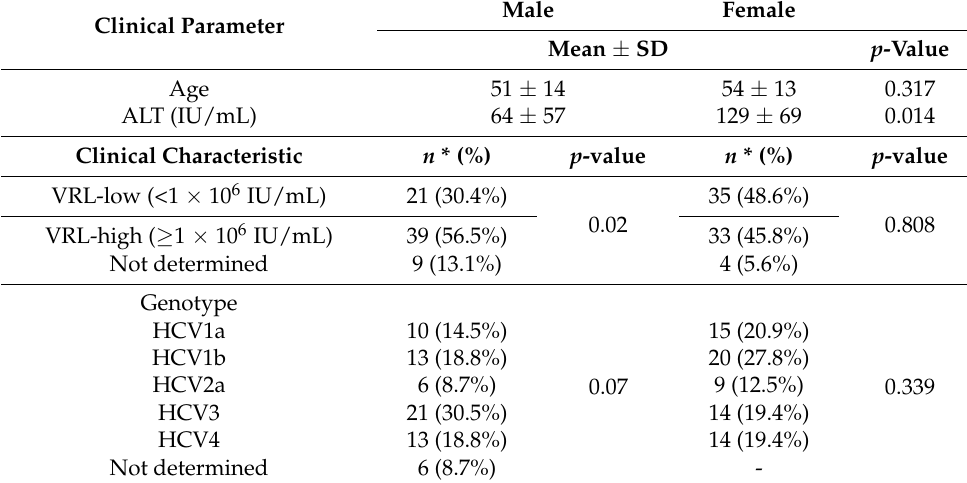
Table A2. Study demographics by